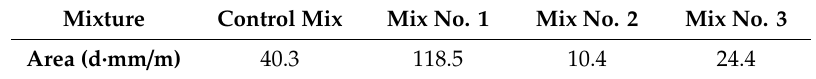
Table 4. Values of areas between deformation curves of samples in Na 2 SO 4 solution and in